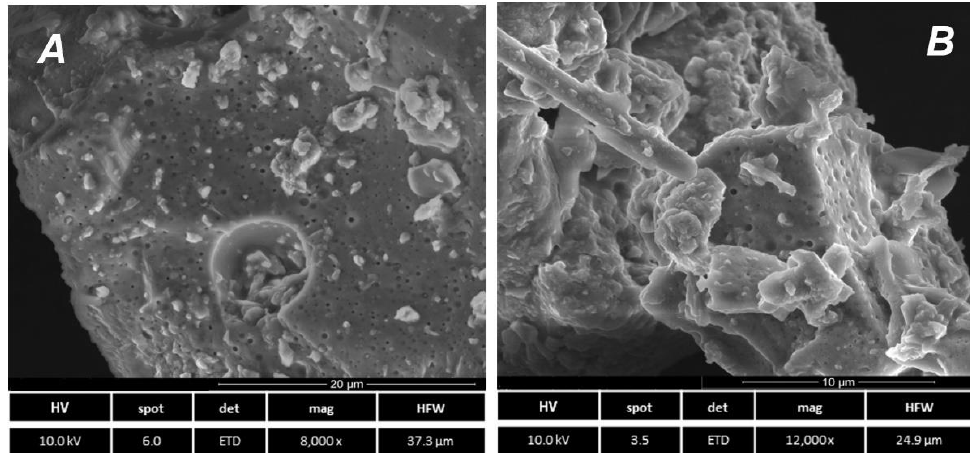
Figure 6. Micrographs obtained through SEM of the catalyst (NaNO 3 /SiAl 20/1) at different magni- fications: 8000 times ( A ) and 12,000 times ( B ).